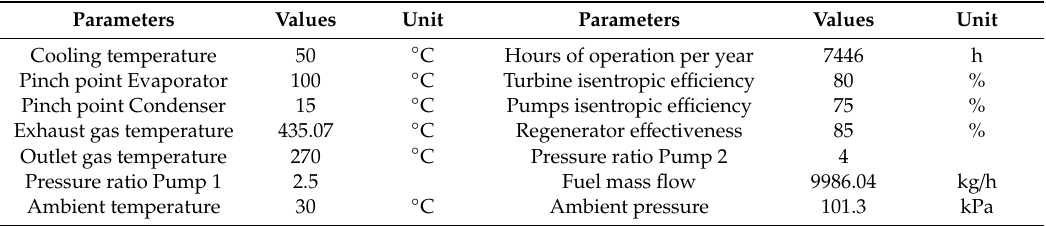
Table 4. Base condition parameters for a regenerative organic Rankine cycle (RORC) system.